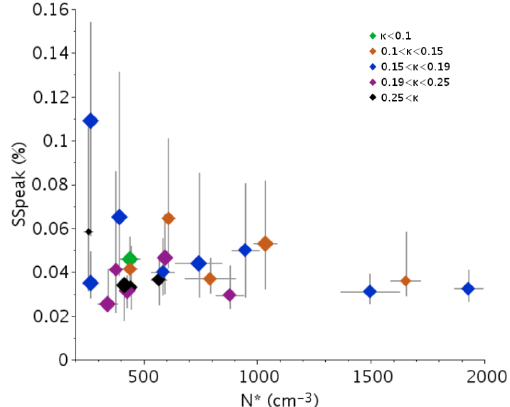
Figure 8. Number concentration of activated particles ( N act ) as a function of N ∗ , the concentration of aerosol particles with diame- ter > 200nm for the 23 fog events. For N ∗ , diamonds correspond to median values and error bars to 25th–75th percentile intervals. Color as a function of κ is indicated in the legend.